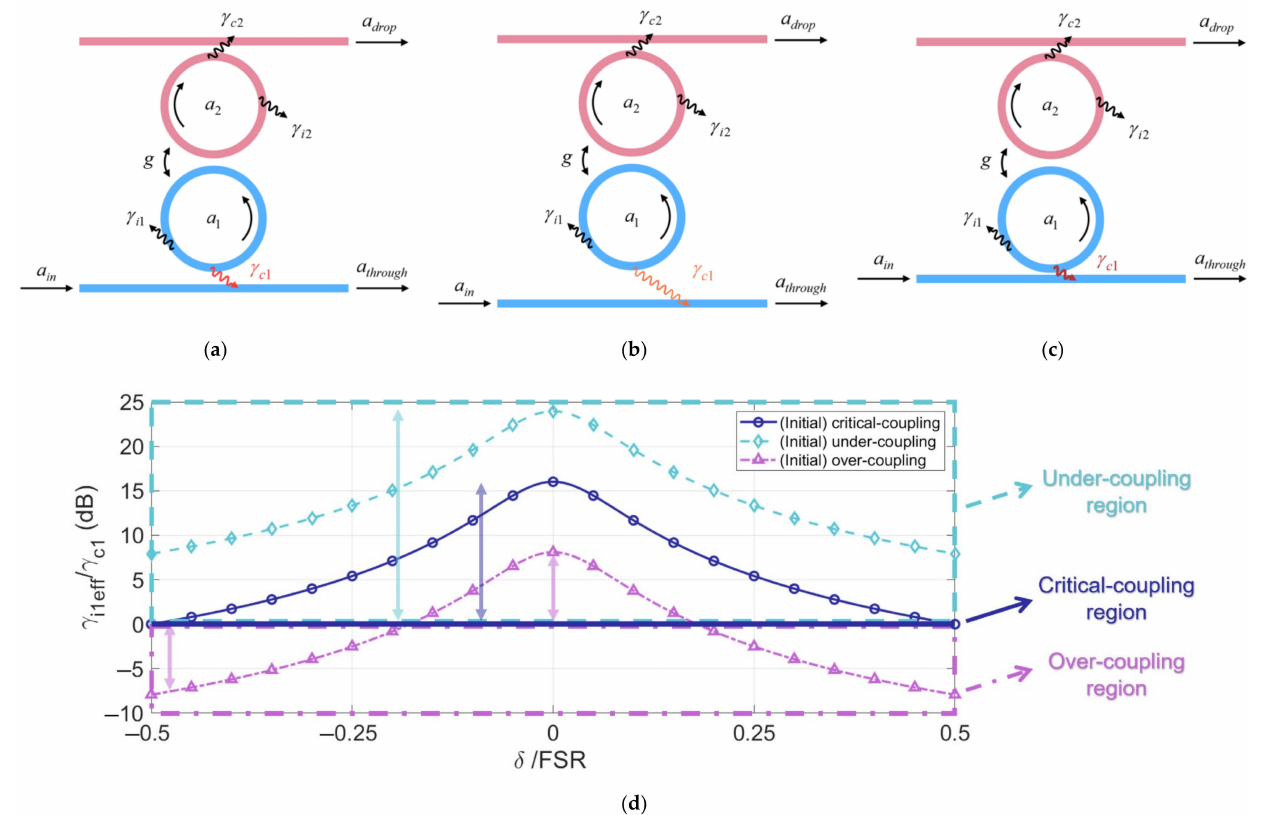
Figure 2. Evolution of system coupling state with detuning under different initial coupling states. ( a – c ) show the schematic diagrams of the system operating at the critical-coupling, under-coupling, and over-coupling conditions at initial detuning, respectively. ( d ) The evolution of the ratio of the effective propagation loss to the coupling loss of the main cavity ( γ i 1 ef f / γ c 1 ) as a function of the detuning δ / FSR